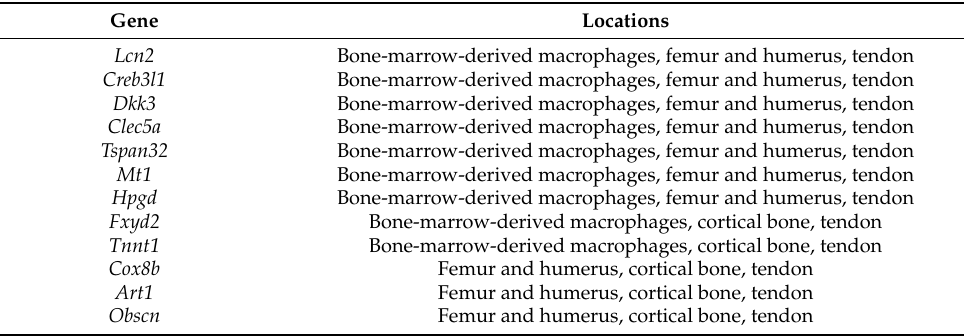
Table 3. List of the most overlapping DEGs in Piezo1 mutant tissues. Gene Locations